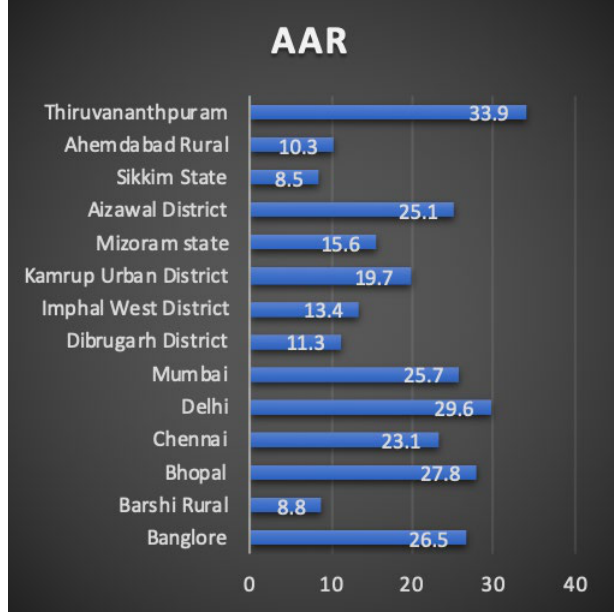
Figure 3. Comparison of AAR (Age Adjusted Rate) of breast cancer (ICD:10:C